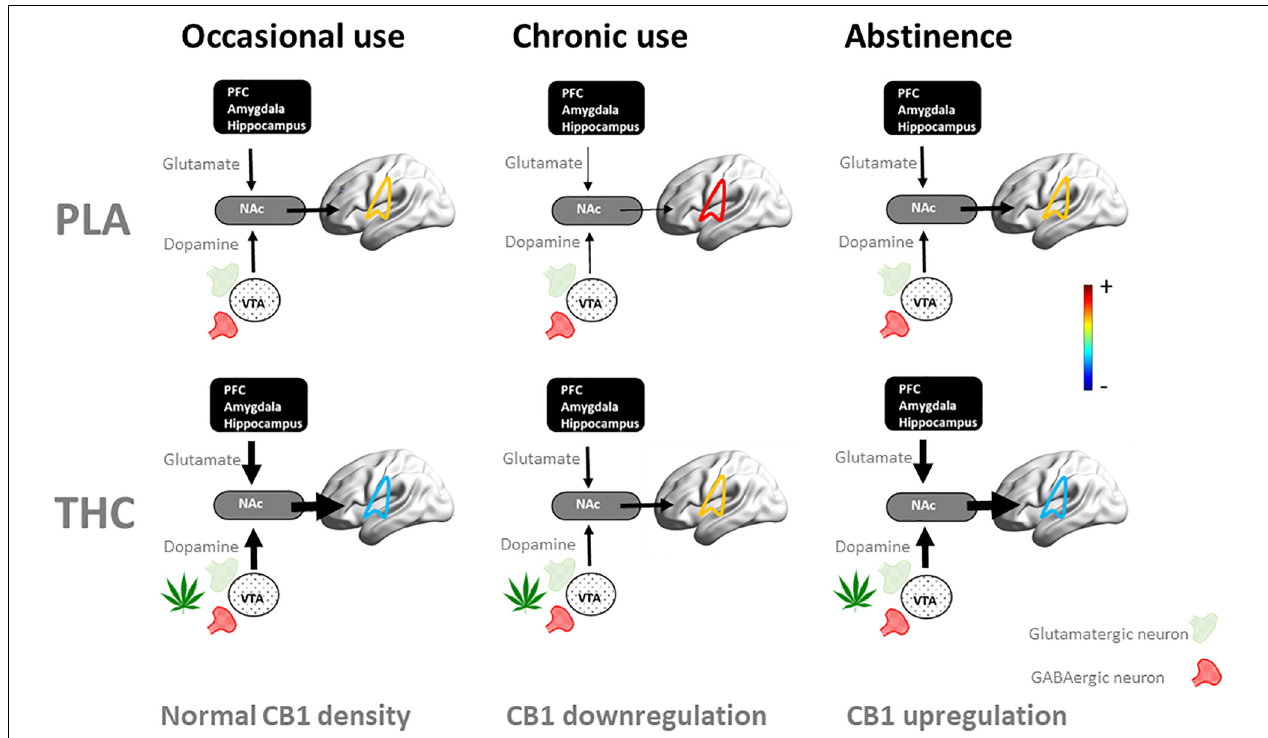
FIGURE 2 | Schematic representation of the dynamics of the neuroadaptive state of the mesocorticolimbic circuit when challenged with placebo (PLA) and THC as users proceed from occasional to chronic cannabis use and into abstinence. In occasional users, an acute THC challenge increases striatal levels of dopamine and glutamate (33–35) through stimulation of CB1 receptors at presynaptic GABAergic and glutamatergic receptors, leading to hypoconnectivity of the mesocorticolimbic circuit (here shown superimposed on brain) and neurocognitive dysfunction (33, 35). With repeated cannabis use, CB1 receptors are downregulated as a neuroadaptive response to CB1 receptor overstimulation (60, 62). In chronic users, this leads to reduced striatal dopamine (40, 41) and glutamate (19–22), as well as hyperconnectivity within the mesocorticolimbic circuit (9, 42, 82) and neurocognitive dysfunction when sober (13, 24, 27, 28). In these users, stimulation of CB1 receptors normalizes striatal dopamine and glutamate concentrations, functional connectivity and neurocognitive function during acute THC intoxication (35). With prolonged abstinence of cannabis, CB1 receptors upregulate (60, 62) and potentially normalize the neuroadaptive and neurocognitive state (63, 64, 66). NAc, nucleus accumbens; PFC, prefrontal